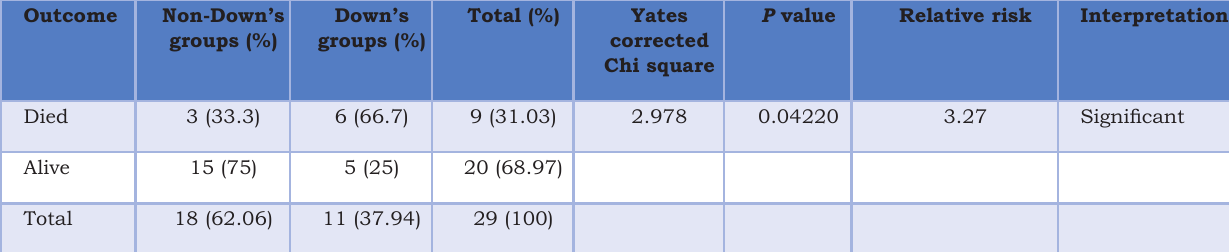
Table 6: The comparison of outcomes (dead/alive) between the two groups